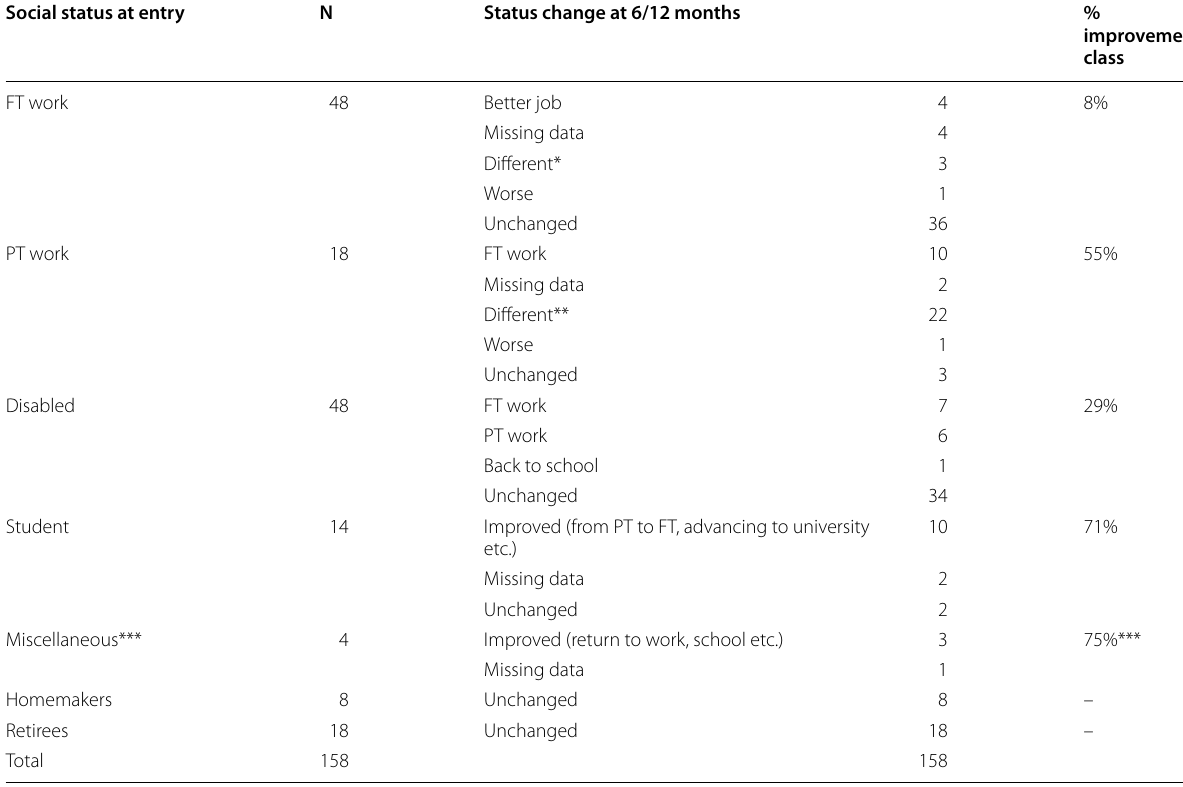
Table 6 Social health